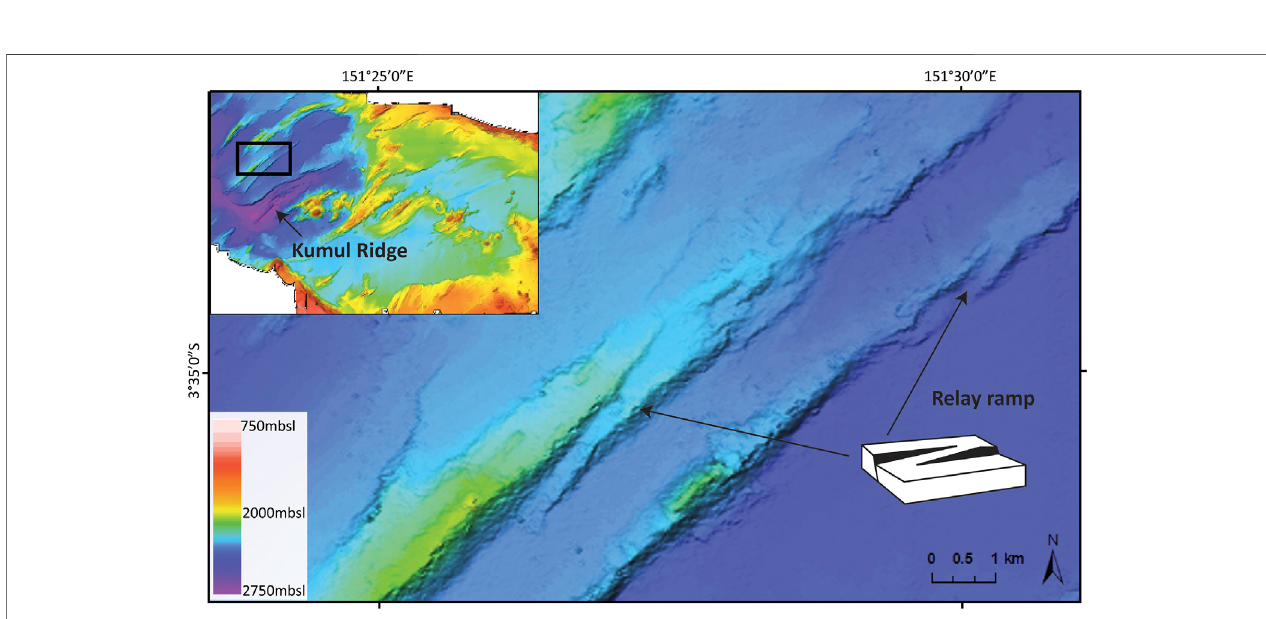
FIGURE 12 | Relay ramps within SFD3, associated with the Kumul Ridge. Relay ramp schematic after Fossen and Rotevatn (2016).